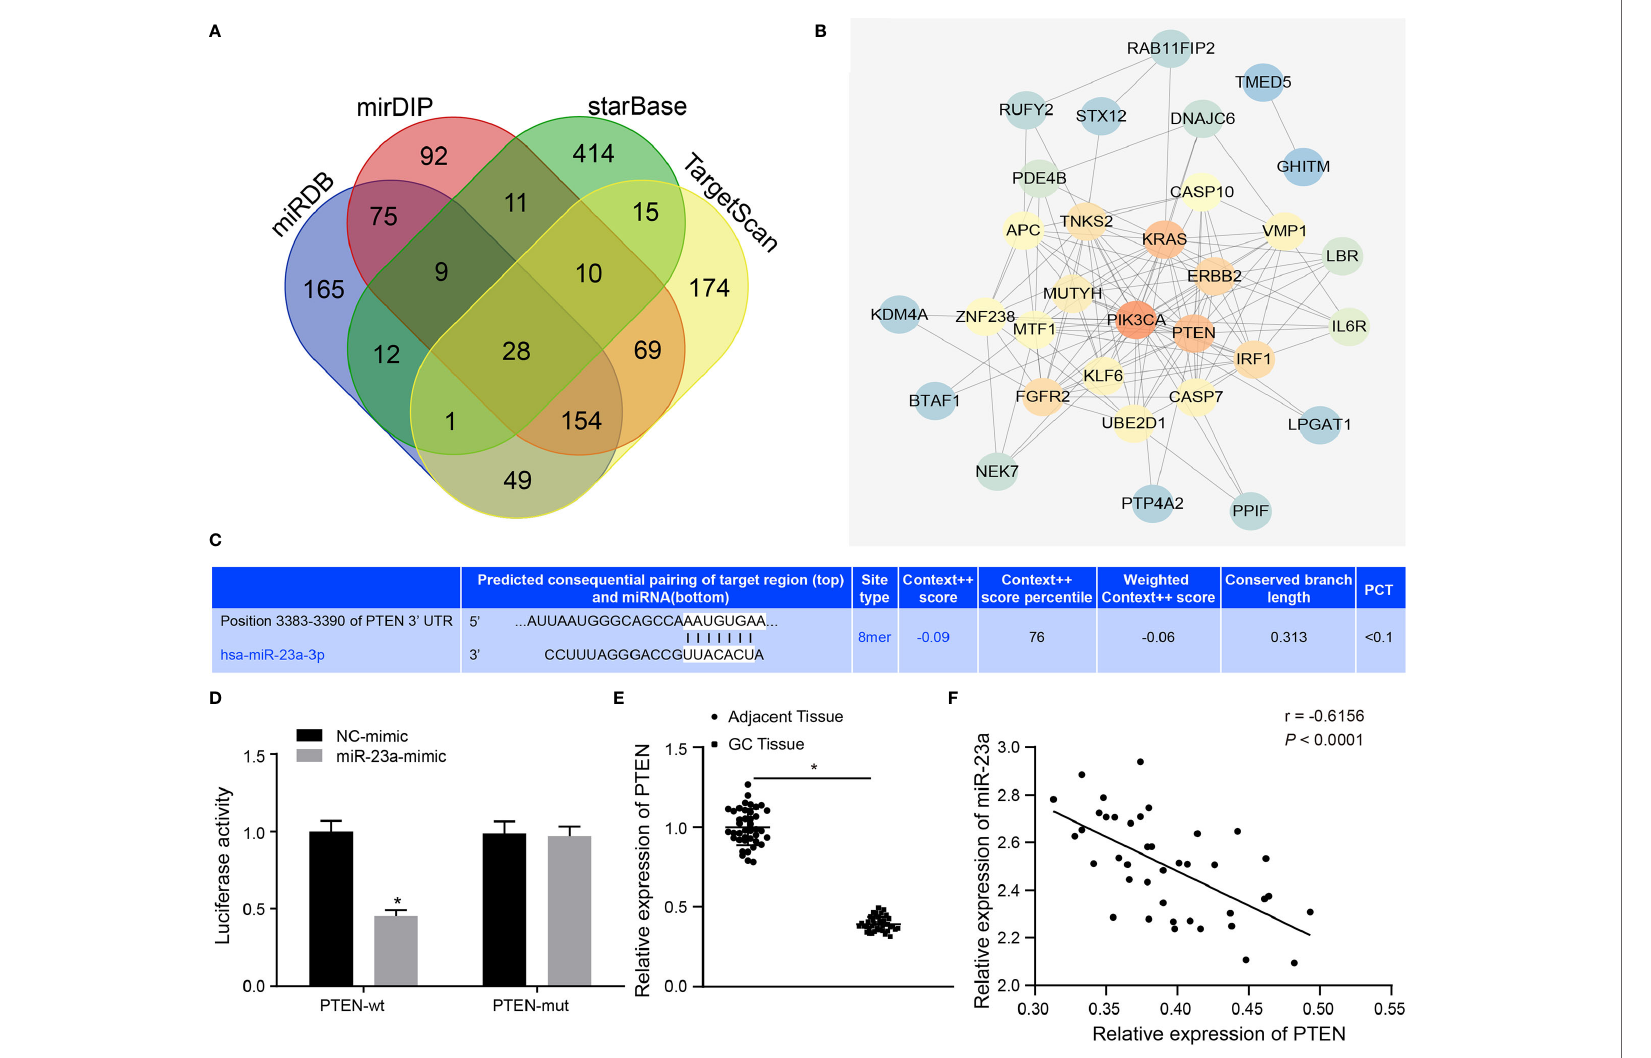
FIGURE 5 | miR-23a targets PTEN and negatively regulated its expression. (A) Intersection of predicted target genes of miR-23a based on the results of four databases, where the middle part represents the intersection. (B) Correlation analysis of the known genes related to GC with target genes of miR-23a. Each small circle in the fi gure represents a gene, and the line between the circles indicates the interaction between two genes. (C) The predicted binding sites of miR-23a on the PTEN by TargetScan website. (D) The binding relationship between miR-23a and PTEN con fi rmed by dual-luciferase reporter gene assay. (E) PTEN expression in GC tissues and adjacent normal tissues detected by RT-qPCR. (F) Correlation between miR-23a and PTEN expression analyzed by Pearson. *p < 0.05 vs. cells transfected with NC-mimic. Measurement data were expressed as mean ± standard deviation. If the data were in compliance with normal distribution and homogeneity, comparisons between two groups were conducted using unpaired t-test. The experiment was repeated three times